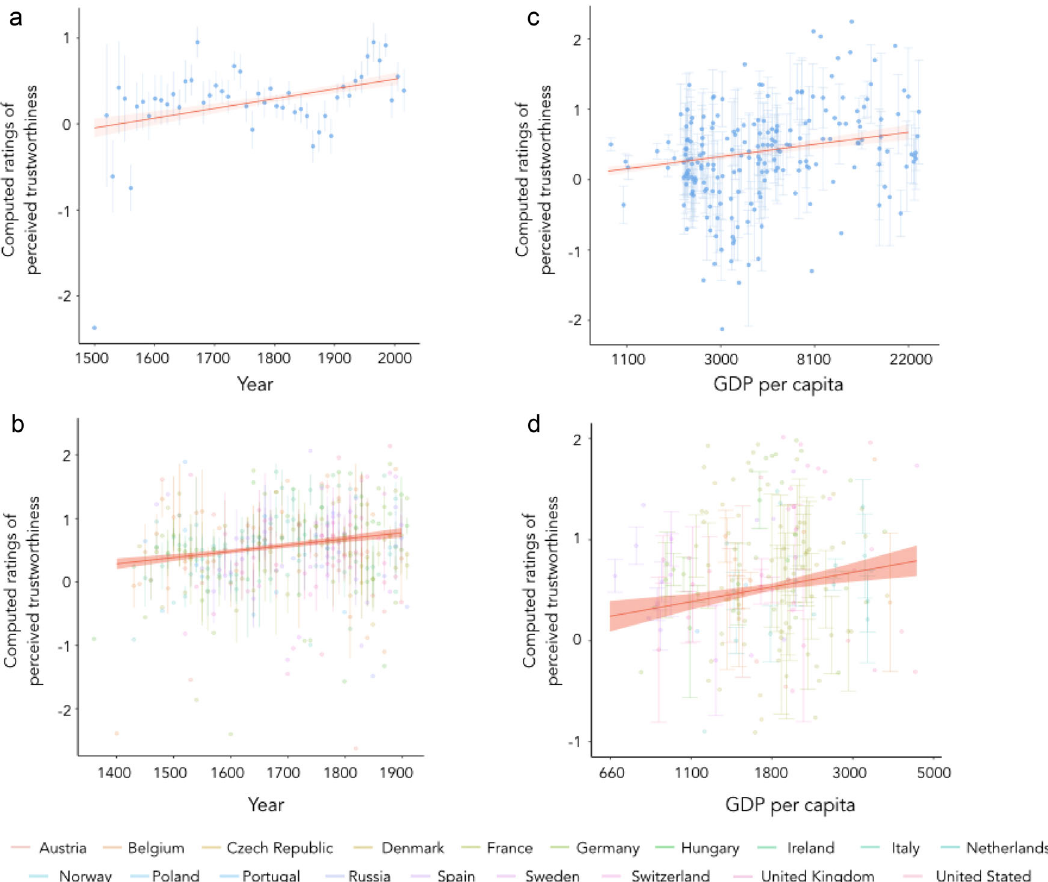
Fig. 2 Effect of time and af fl uence on ratings of perceived trustworthiness across time. Time was associated with an increase of ratings of perceived trustworthiness displays in both the National Portrait Gallery ( a data are aggregated by decade; regression line corresponds to the analysis on individual portraits) and the Web Gallery of Art ( b ) — data are aggregated country and by decades; regression line corresponds to the analysis on individual portraits). Increased GDP per capita predicted increased ratings of perceived trustworthiness displays better than time only-models both in the National Portrait Gallery ( c data are aggregated by GDP; regression line corresponds to the analysis on individual portraits) and the Web Gallery of Art ( d data are aggregated by country and GDP; regression line correspond to the analysis on individual portraits). Data are represented as mean values, error bars represent standard error to the means, the red line corresponds to the estimated effect in the regression adjusting for gender, age (for the National Portrait Gallery only) and perceived dominance, the shaded area represents the standard error to the mean of these effects. Source data are provided as raw data and scripts on the online